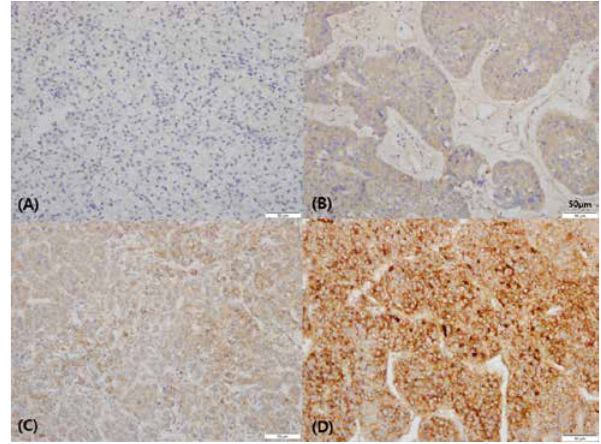
Figure 2: Immunohistochemical analysis for VEGF in HCC. (a) VEGF(−), (b) VEGF(+) (weak positive), (c) VEGF(++) (moderate posi- tive), and (d) VEGF(+++) (strong positive)